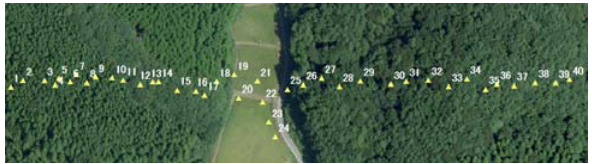
Figure 3. Experiment area